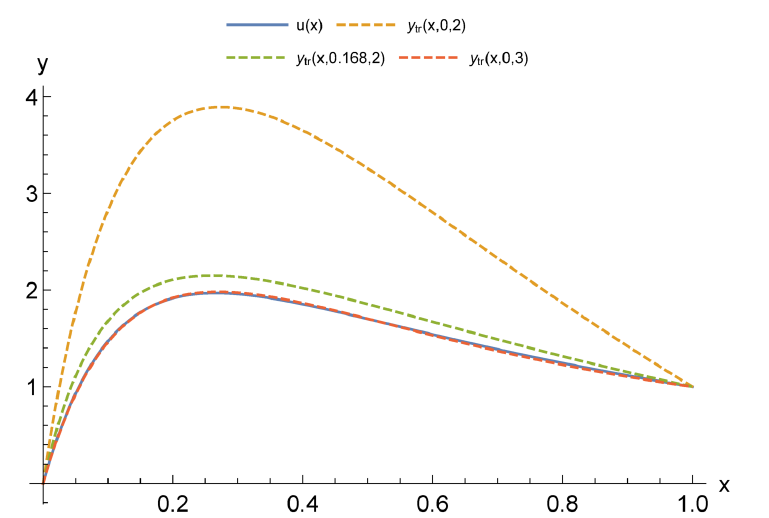
Figure 14. Plots of multilayer solutions y tr ( x ,0,2 ) , y tr ( x ,0.168,2 ) , y tr ( x ,0,3 ) (number of layers n = 2,2,3) as applied to problem (30) and its exact solution u ( x ) (parameter value s = 0.1), corre- sponding to dashed lines and solid line,